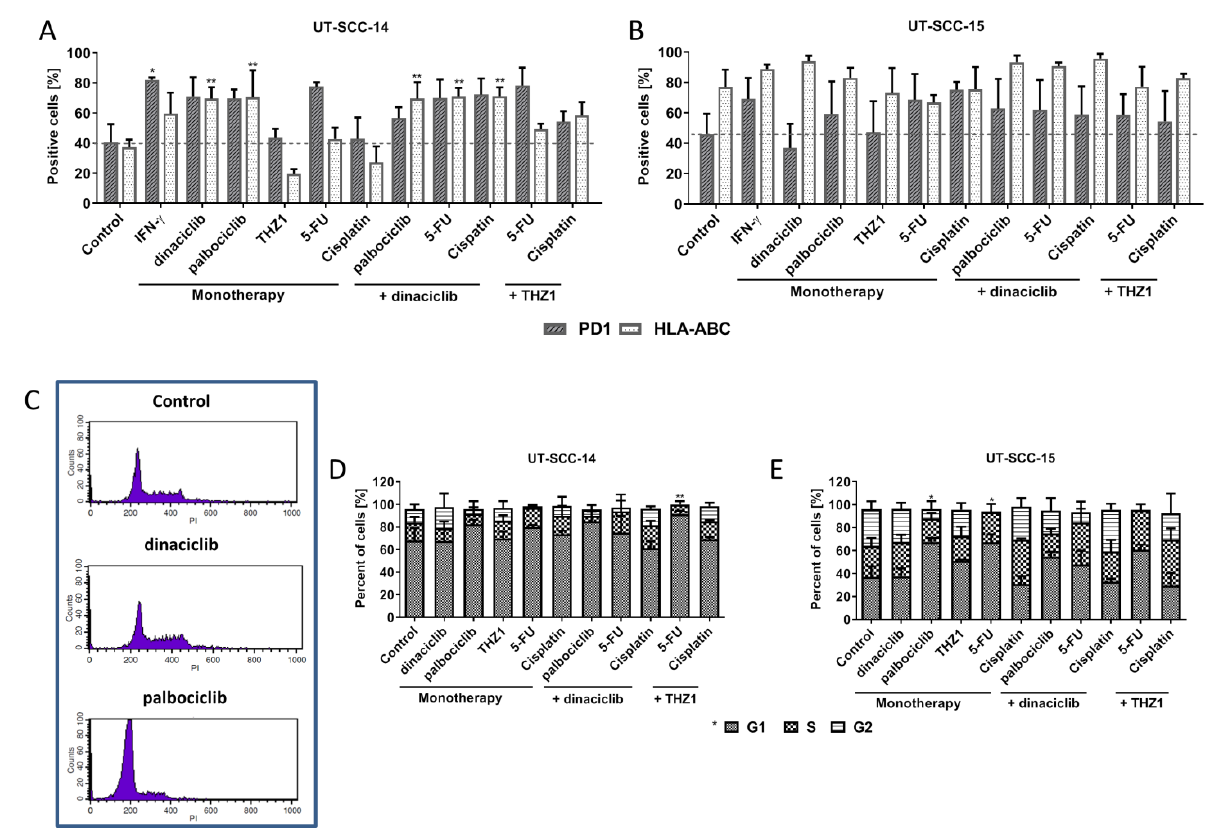
Figure 3. Phenotyping and cell cycle analysis. Phenotyping of ( A ) UT-SCC-14 and ( B ) UT-SCC-15 cells using multi-color flow cytometry. Therefore, cells were stained after 48 h treatment with test substances using the following antibodies: anti-HLA-ABC antibody (MHC I) and anti-CD279 (PD-1). Drug doses were as follows: IFN-γ [50 ng/mL]; dinaciclib [0.02 µM]; palbociclib [1 µM]; THZ1 [UT-SCC14: 0.02 µM; UT-SCC-15: 0.005 µM]; 5-FU [90 µg/mL]; Cisplatin [0.1 µg/mL]. 1 way ANOVA ( n ≥ 3 independent experiments) * p < 0.05, ** p < 0.01, vs. control. ( C – E ) Cell cycle analysis. Ethanol-fixed cells were stained with PI. ( C ) Representative histograms showing distribution of cell cycle phases in control cells and upon therapy. ( D , E ) Quantitative cell cycle analysis showing amounts of cells in G1, S, and G2 phase. Drug doses were as follows: dinaciclib [0.005 µM]; palbociclib [1 µM]; THZ1 [UT-SCC14: 0.02 µM; UT-SCC-15: 0.005 µM]; 5-FU [90 µg/mL]; Cisplatin [0.1 µg/mL]. 1way ANOVA ( n = 3 independent experiments) * p < 0.05, ** p < 0.01 vs. control.